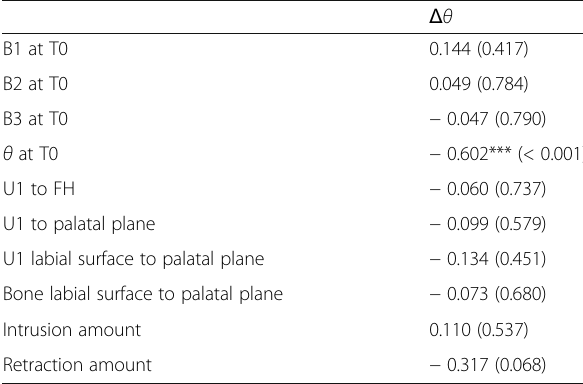
Table 3 Correlation between mean changes of the angle